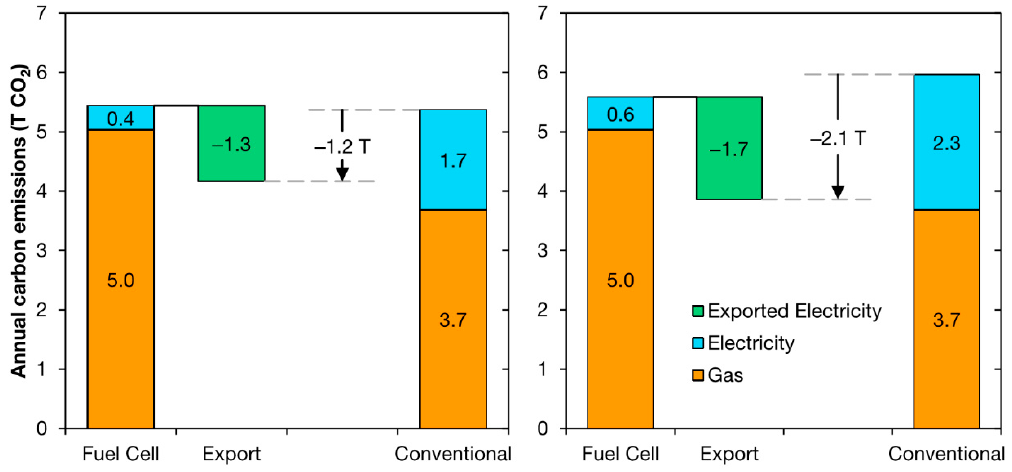
Figure 6. Yearly carbon emission for a UK household [113].